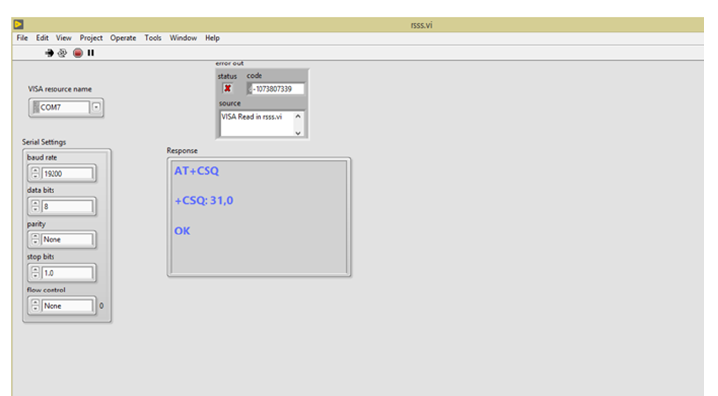
Figure 7. RSSI acquisition process.